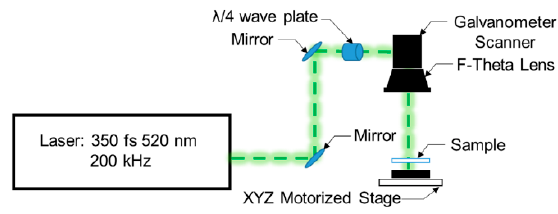
Figure 1. Optical setup of femtosecond laser lift-off (LLO) system.